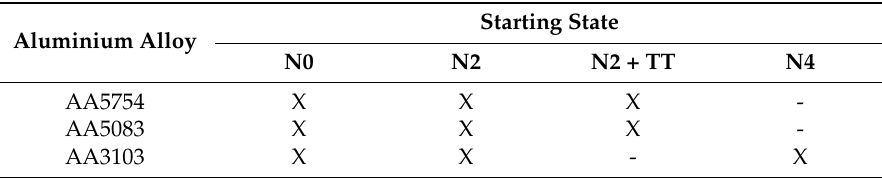
Table 1. Aluminium alloys and starting states under